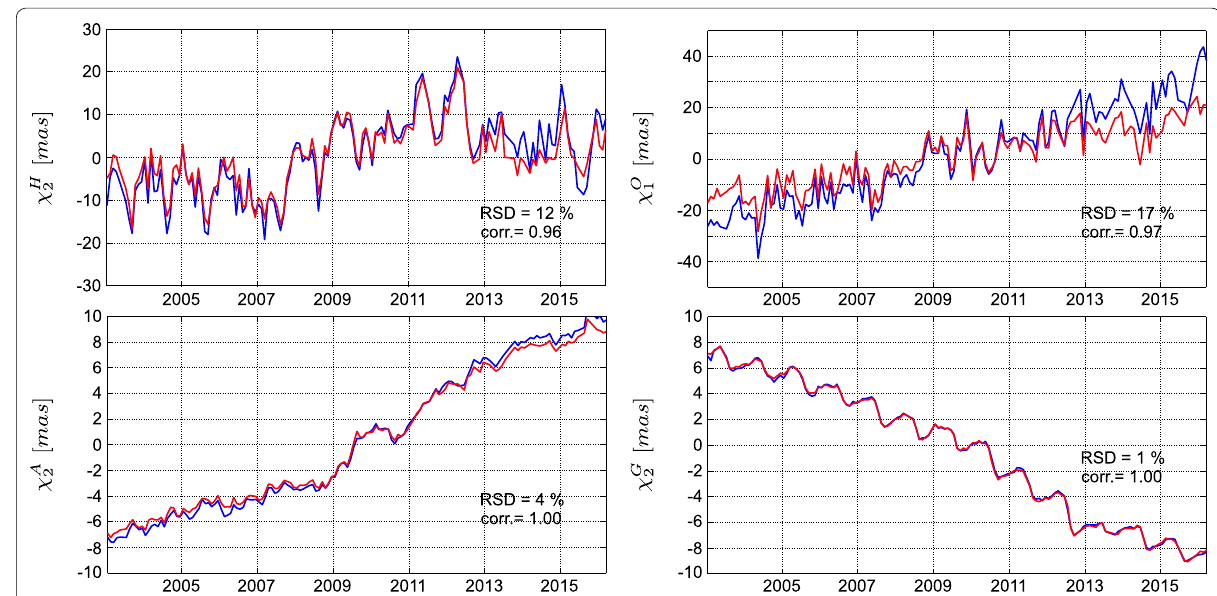
Fig. 6 Excitation functions from CSR RL05 DDK2 (blue) and CSR RL06 DDK2 (red) for the mass effects of the continental hydrosphere χ H , the oceans χ O , Antarctica χ A and Greenland χ G (mean values of the time series are removed)